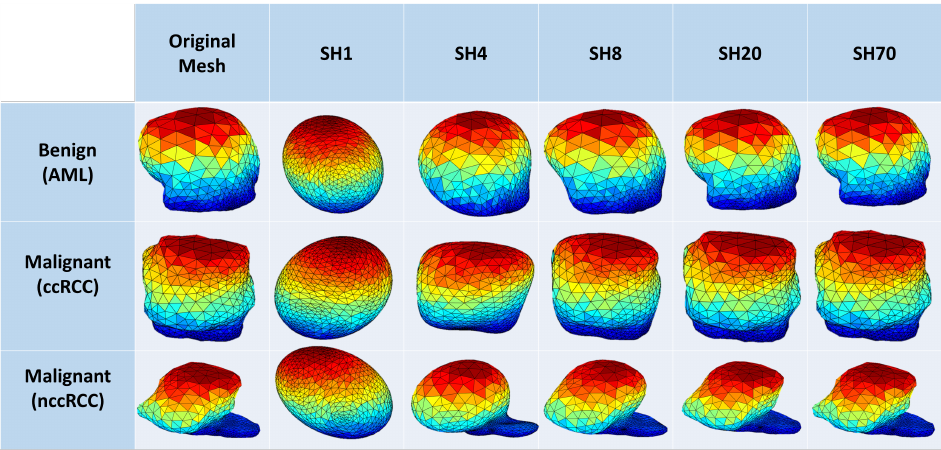
Figure 4. Renal tumors’ reconstruction meshes showing the morphological differences among malignant ccRCC, malignant nccRCC, and benign AML